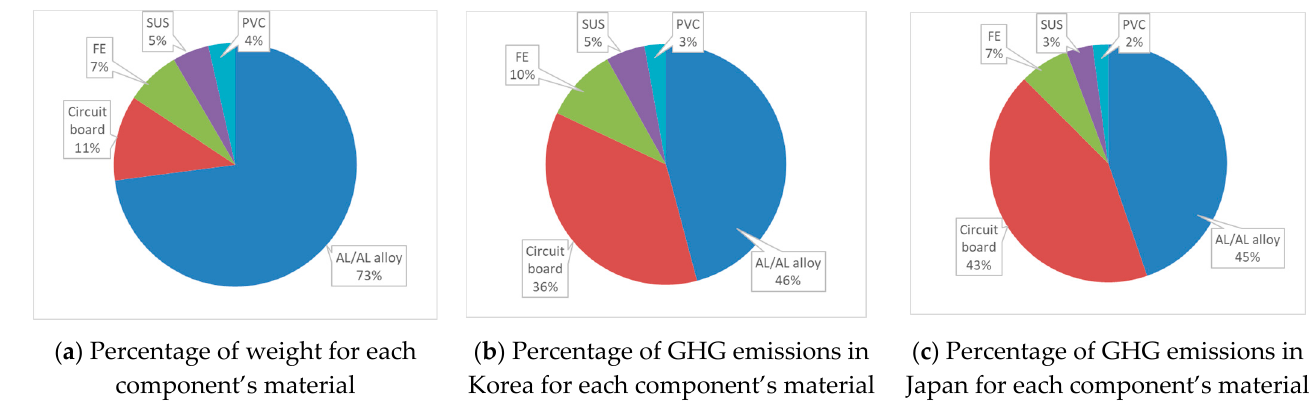
Figure 7. Percentage of each component’s material ( a ) based on weight; ( b ) based on GHG emissions in Korea; ( c ) based on GHG emissions in Japan.